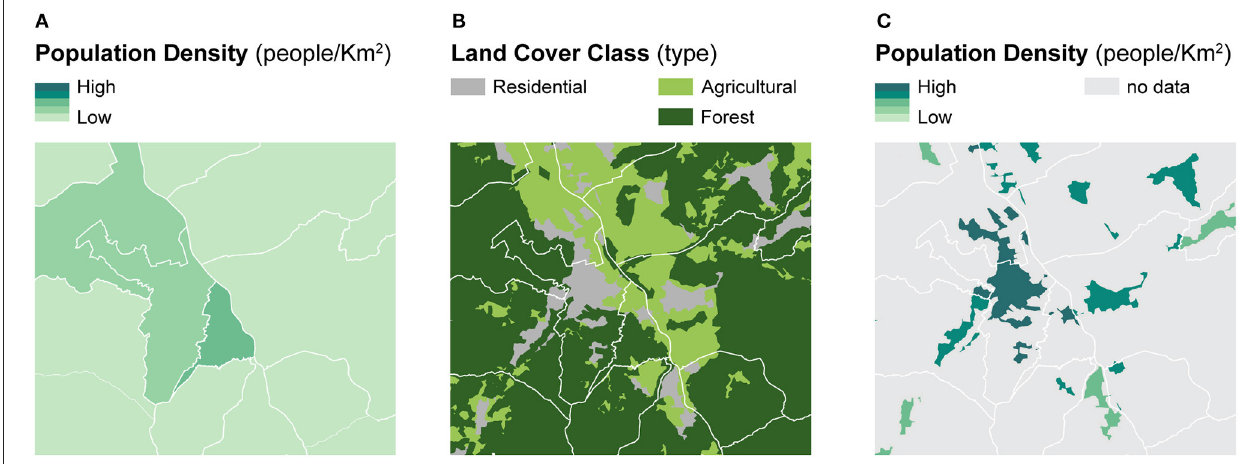
FIGURE 1 | A framework for dasymetric refinement of population data within residential land. Example of binary dasymetric refinement of population data within residential land — (A) population density computed within administrative units is refined based on (B) the location of residential land to recompute (C) population density within dasymetrically refined